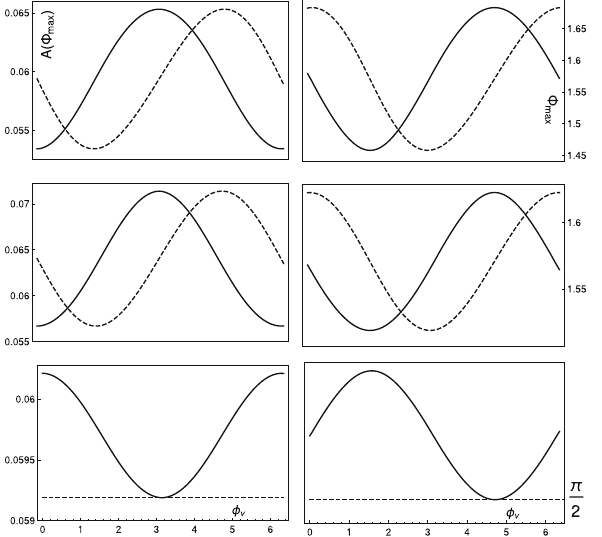
Fig. 5 Dependence of A (Φ max ) on φ ν (solid line) and Φ max on φ ν (dashed line), for ˆ η ν · ˆ q = − 0 . 95 , E ν = 1 MeV . TRSC: upper left plot | = 0 . 2 ,θ = 0;middleleftplot forthecaseof V − A and S R when | c R S , R S | = 0 . 2 ,θ = 0;lower forthecombinationof V − A with T R when | c R T , R T | = 0 . 2 ,θ = 0. left plot for the case of V − A with P R when | c R P , R P TRSV: upper right plot for the scenario with V − A and S R when | c R | = 0 . 2 ,θ = π/ 2; middle right plot for the case of V − A and S , R S | = 0 . 2 ,θ = π/ 2; lower right plot for the combination T R when | c R T , R T Fig. 7 Upper plot: dependence of Φ max on Δθ ST , R for θ ν = π, E ν = | = 0 . 2 ,θ = π/ 2. of V − A with P R when | c R P , R P 1 MeV in the case of V − A with S R and T R when | c R (dashed line); plot of Φ max on Δθ PT , R for θ ν = π, E ν = 1 MeV in the presence of V − A , P R and T R when | c R Lower plot: dependence of A (Φ max ) on Δθ ST , R (dashed line) and on Δθ PT , R (dotted line), respectively, with the same assumptions as for